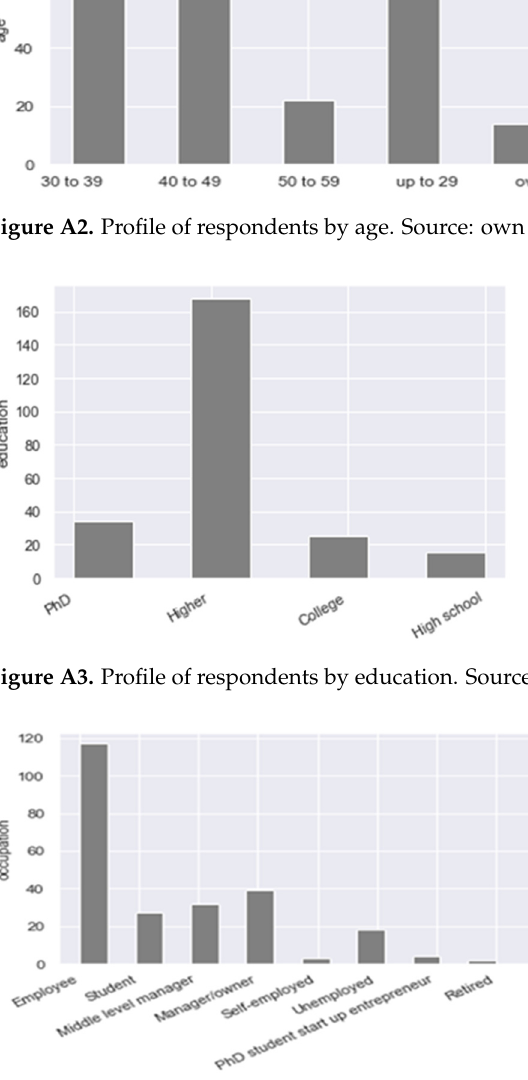
Figure A4. Profile of respondents by occupation. Source: own research.